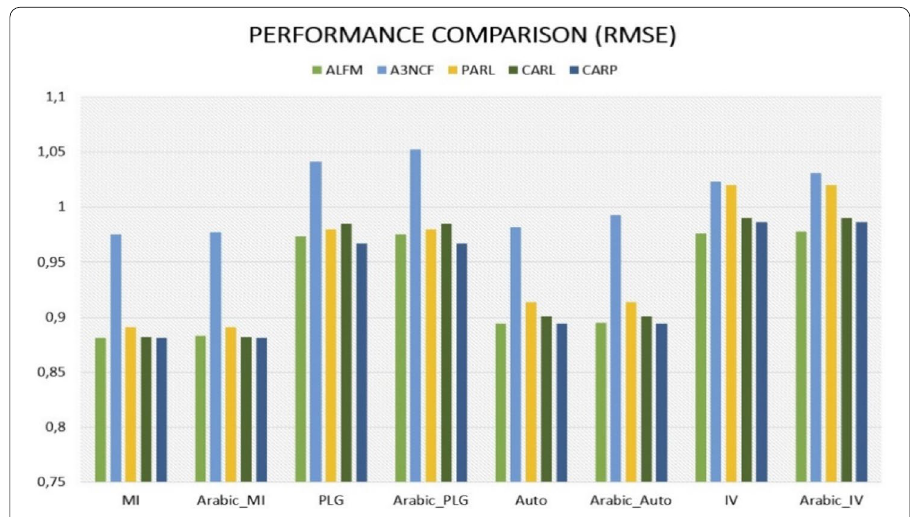
Fig. 4 Comparing the adopted recommendation models in the English and Arabic